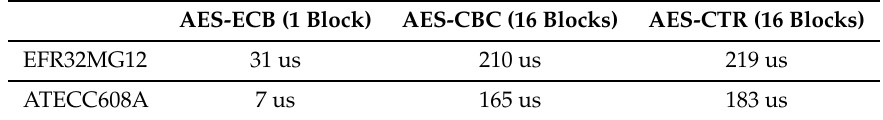
Table 4. Experimental comparison of the two security modules included in the Cookie platform, considering the computational time for different AES modes AES-ECB (1